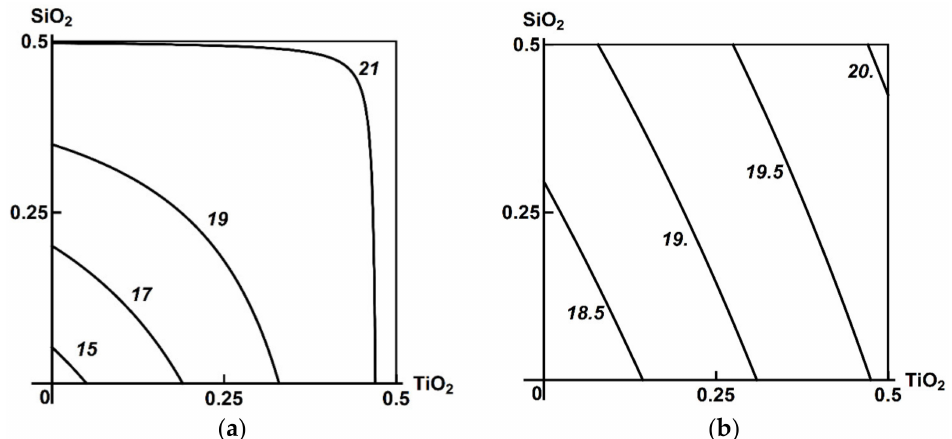
Figure 6. An example of Class A three-factor toxicity. Isobolograms of SiO 2 + TiO 2 combined subchronic liver toxicity assessed by the increase in the number of Kupffer cells as follows: ( a ) an- tagonism of unidirectional actions in the absence of a third agent and ( b ) additivity in the presence of Al 2 O 3 NPs. MeO NP doses on the axes are plotted in mg per rat. Numbers on the isoboles show effect values.